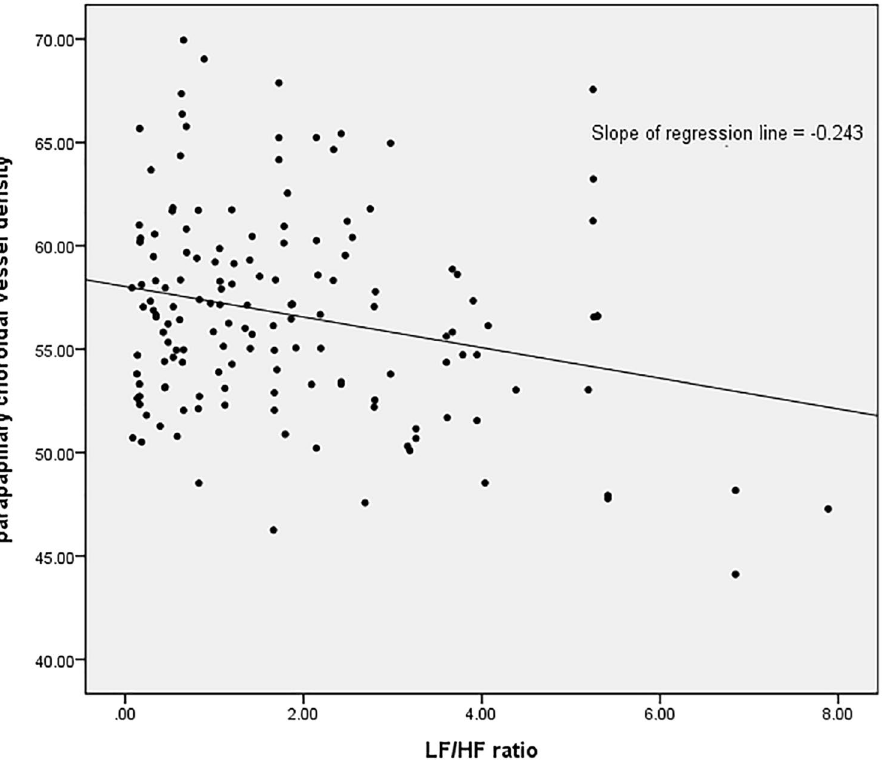
Figure 1. Scatter plot showing the relationships between the parapapillary choroidal vessel density and LF/HF